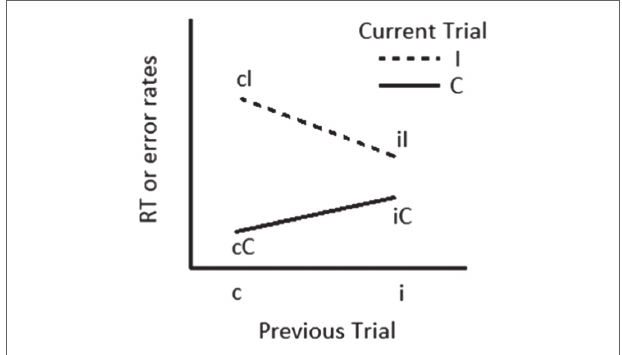
FIGURE 2 | The sequential congruency effect (SCE) is calculated using the following formula: (cI – cC) – (iI – iC). Larger SCEs reflect slower disengagement of attention from previous information on current trial performance. C and c refer to congruent trials. I and i refer to incongruent